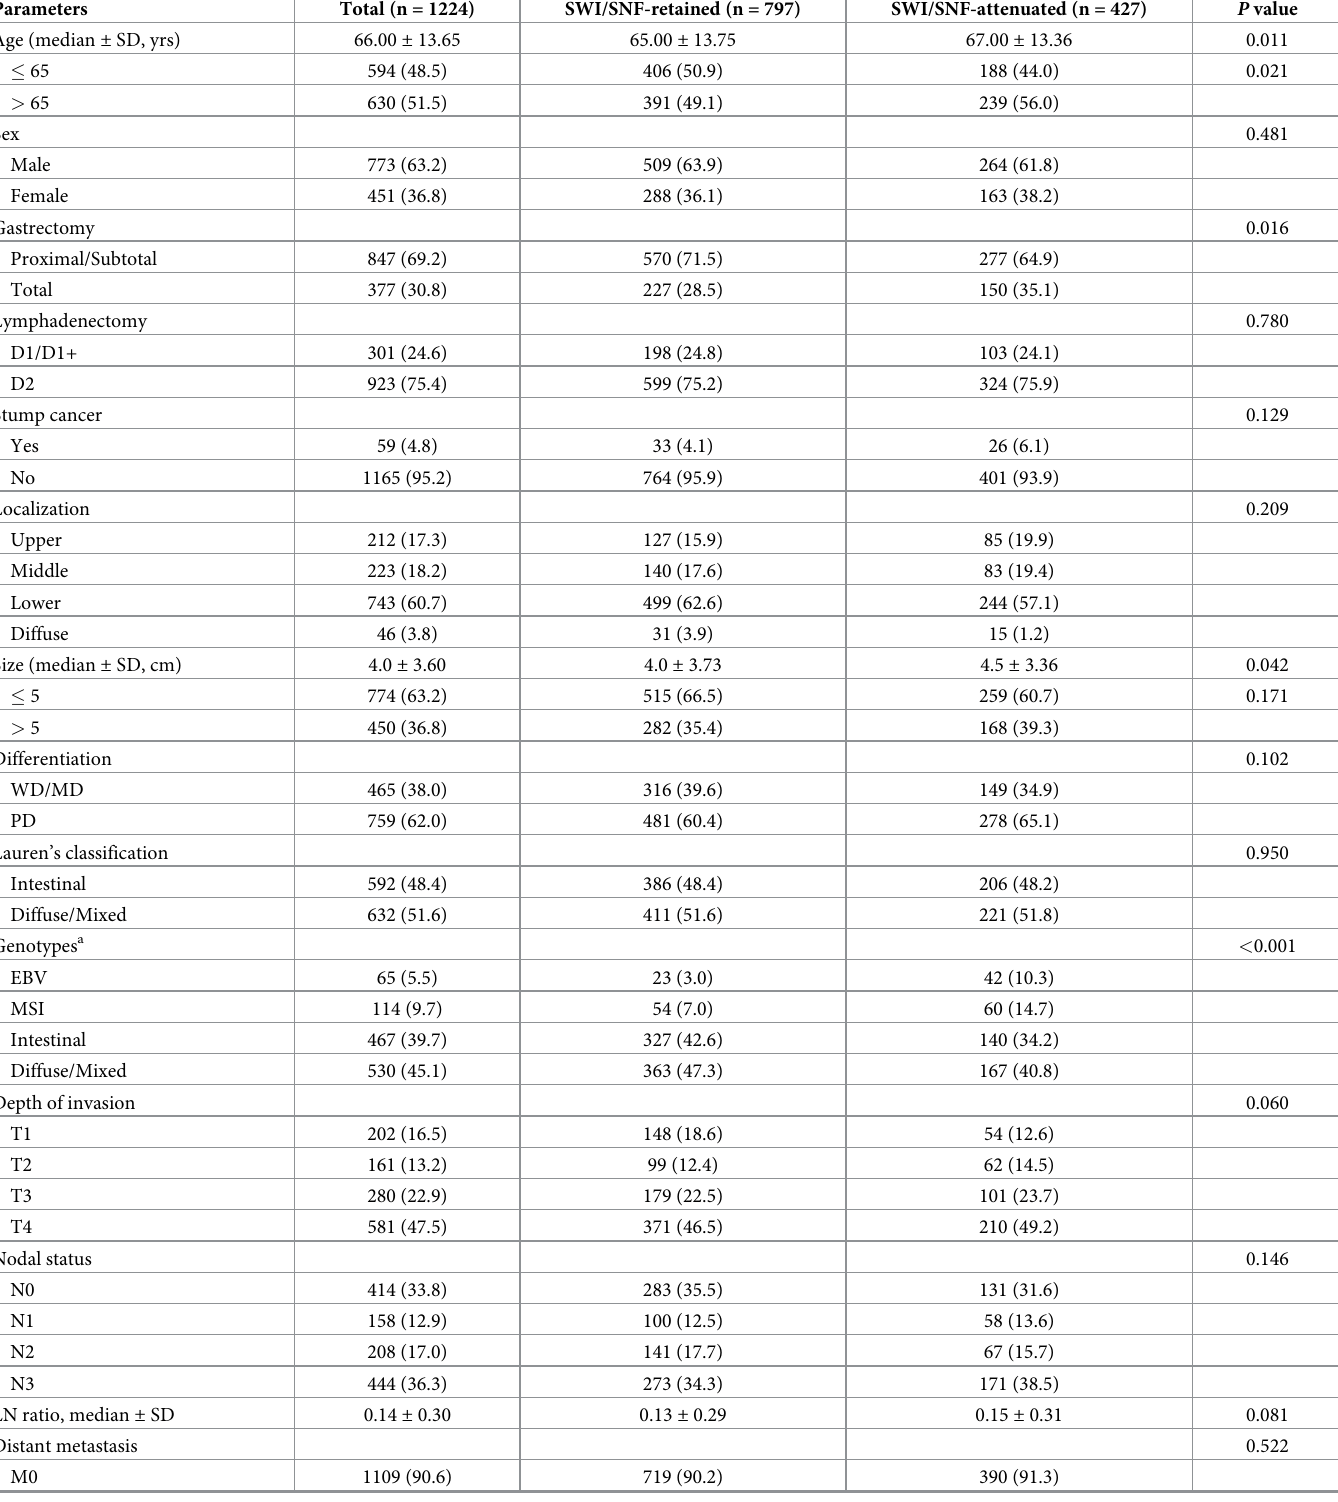
Table 1. Clinicopathological differences between SWI/SNF-retained and SWI/SNF-attenuated gastric